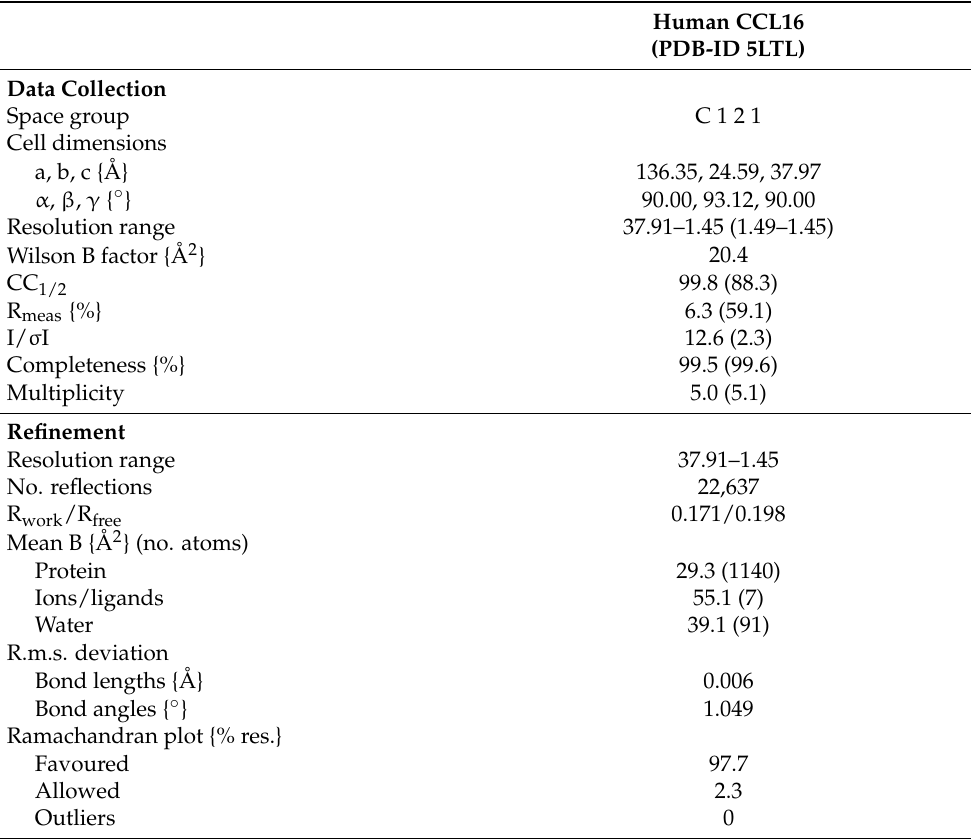
Table 1. Data collection and refinement statistics (r.m.s., root-mean-square). Values in parentheses refer to the highest-resolution